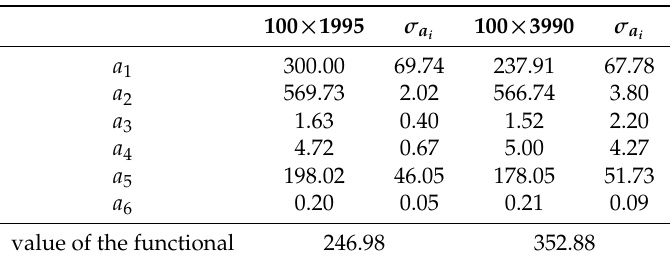
Table 1. Results of calculation for grids 100 × 1995 and 100 × 3990 ( a i —reconstructed value of parameter, σ a —standard deviation ( i = 1,2, . . . ,6)). i